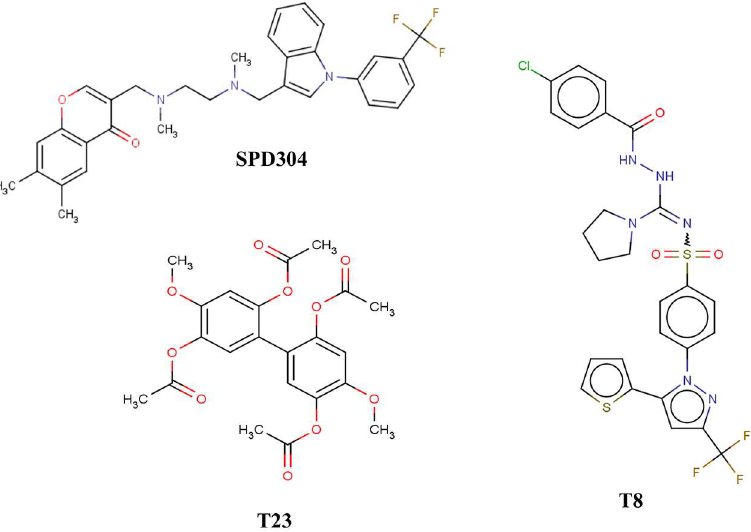
Fig 1. Chemical structuresof compounds SPD304 (published inhibitor), and T8, T23 (the two most potent inhibitors identified by our